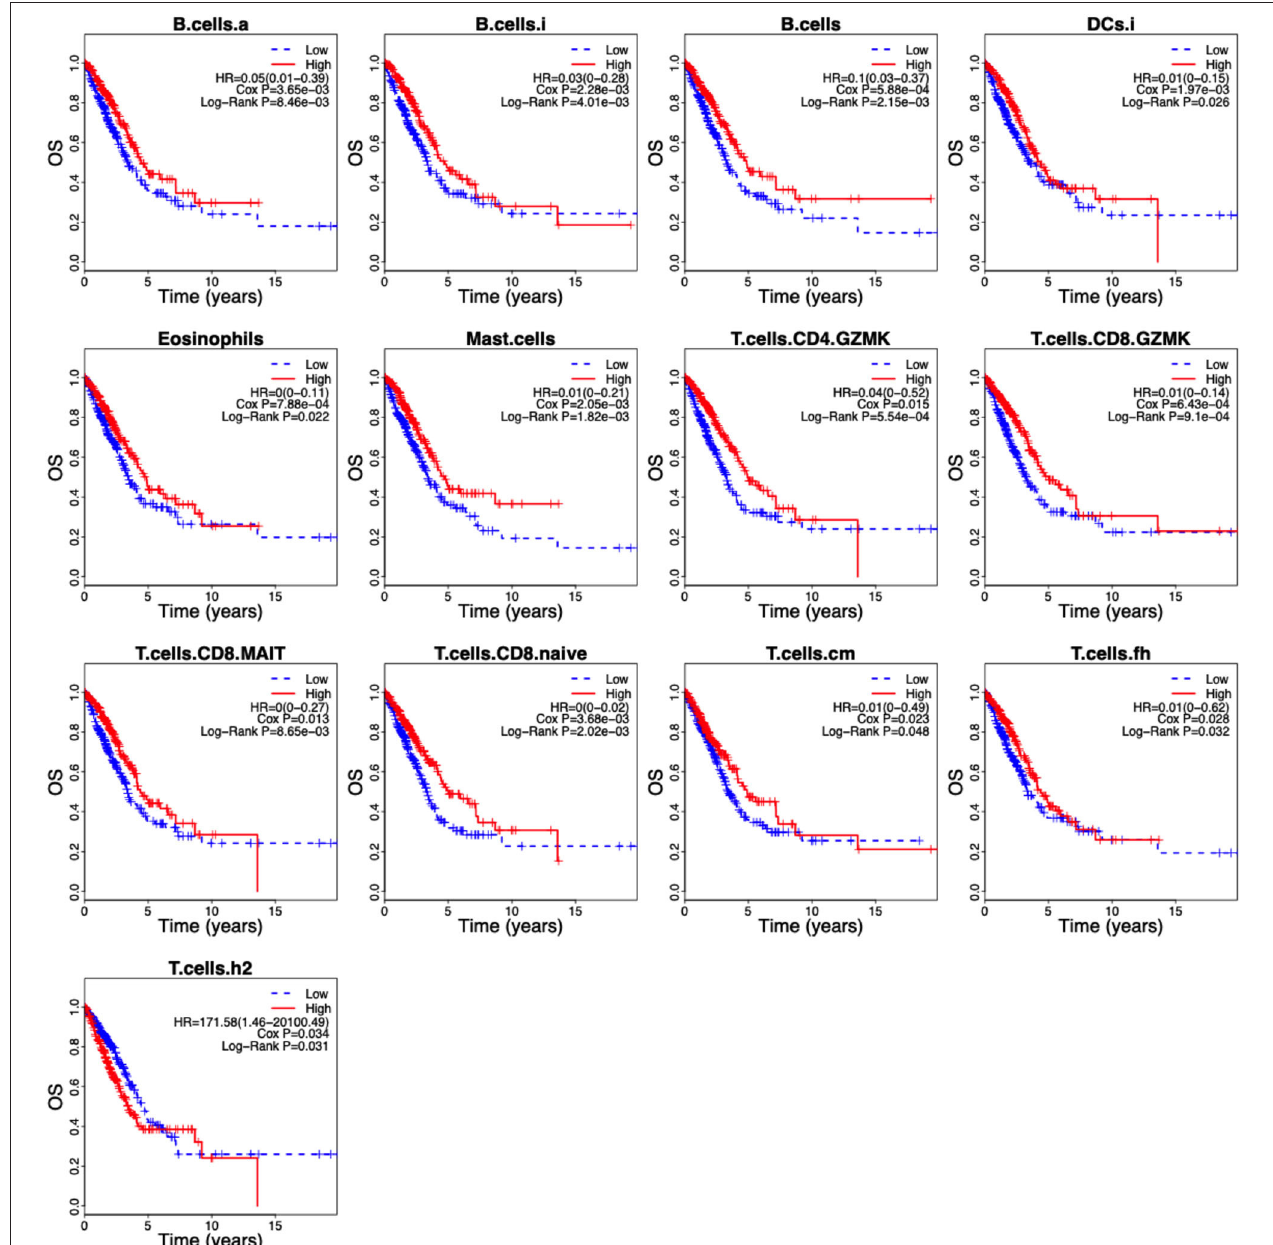
FIGURE 4 | Kaplan–Meier curves of the 13 infiltrating immune cells in LUAD. The association between the infiltrating immune cells and the overall survival of LUAD patients was investigated using Cox regression and log-rank methods. Kaplan–Meier curves was drawn by the “survival” package based on R.